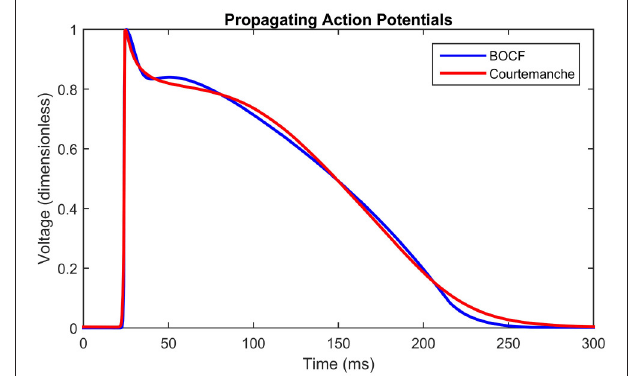
FIGURE 3 | Propagating action potentials. Plots of Courtemanche (Courtemanche et al., 1998) (blue), and BOCF (Bueno-Orovio et al., 2008) (red) models using the parameters in Table 1 , of an AP at a point 10 mm from the stimulus with a spatial resolution of 0.2mm and a time step of 0.01ms. Model calibrated by minimizing the root mean squared error using the Nelder-Mead method. The Courtemanche model is solved using the parameters in Courtemanche et al. (1999).